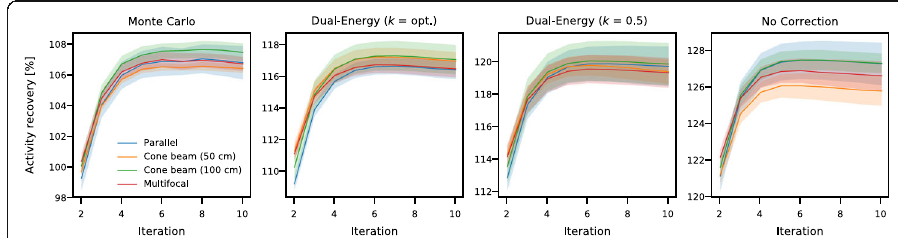
Fig. 7 Activity recovery in the tumor, collected per scatter correction method. The shaded bars indicate the standard deviation retrieved from the ten noise